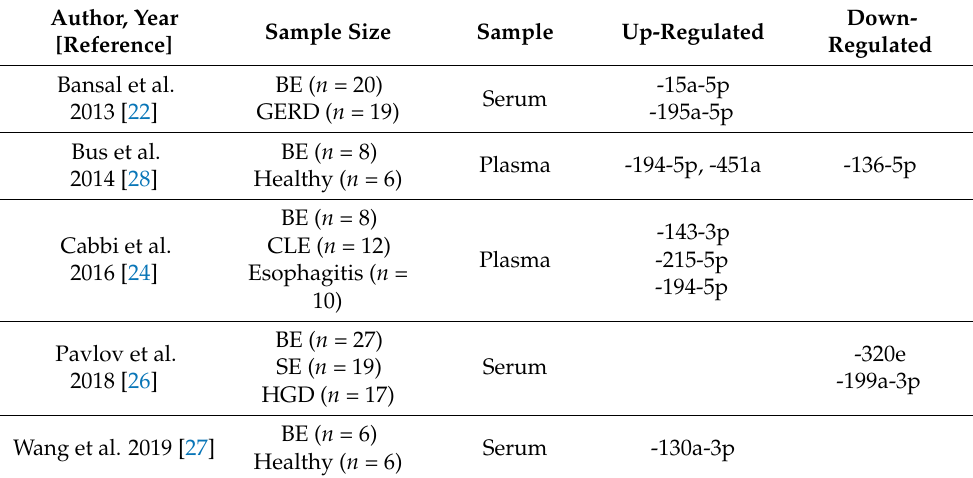
Table 1. MiRNAs used to detect